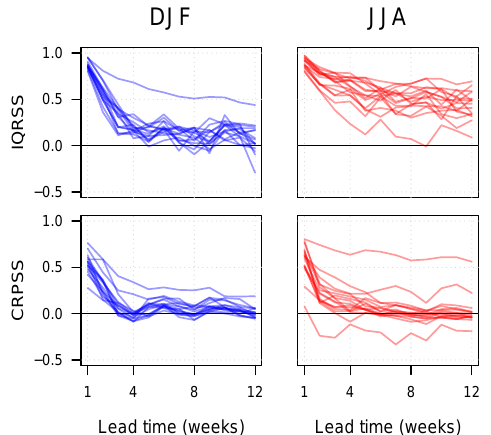
Figure 11. Skill of streamflow forecasts obtained from precipitation forecasts corrected with EDMD-m as a function of the lead time for all catchments and for the winter (DJF) and summer (JJA) seasons. The skill is computed based on the IQR (top) and the CRPS (bot- tom) and the reference is ESP. Each column corresponds to a target season. Each line represents the skill score in a catchment for fore- cast horizons within the target season.